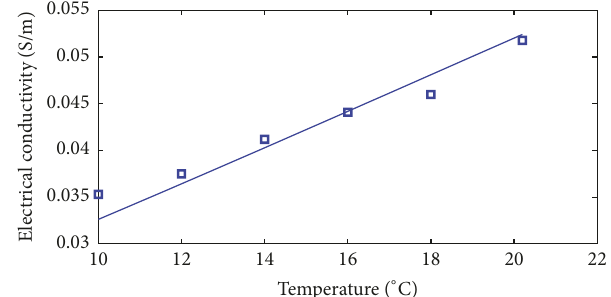
Figure 10: Electrical conductivity of the mixture as a function of temperatureat the critical composition (32.1%). The square symbols are the measured data and the solid line is the fitting one from (4) with the parameters A = 0.37mS/cm, B = 102.0 𝐾 −1 , and 𝑇 𝑔 =